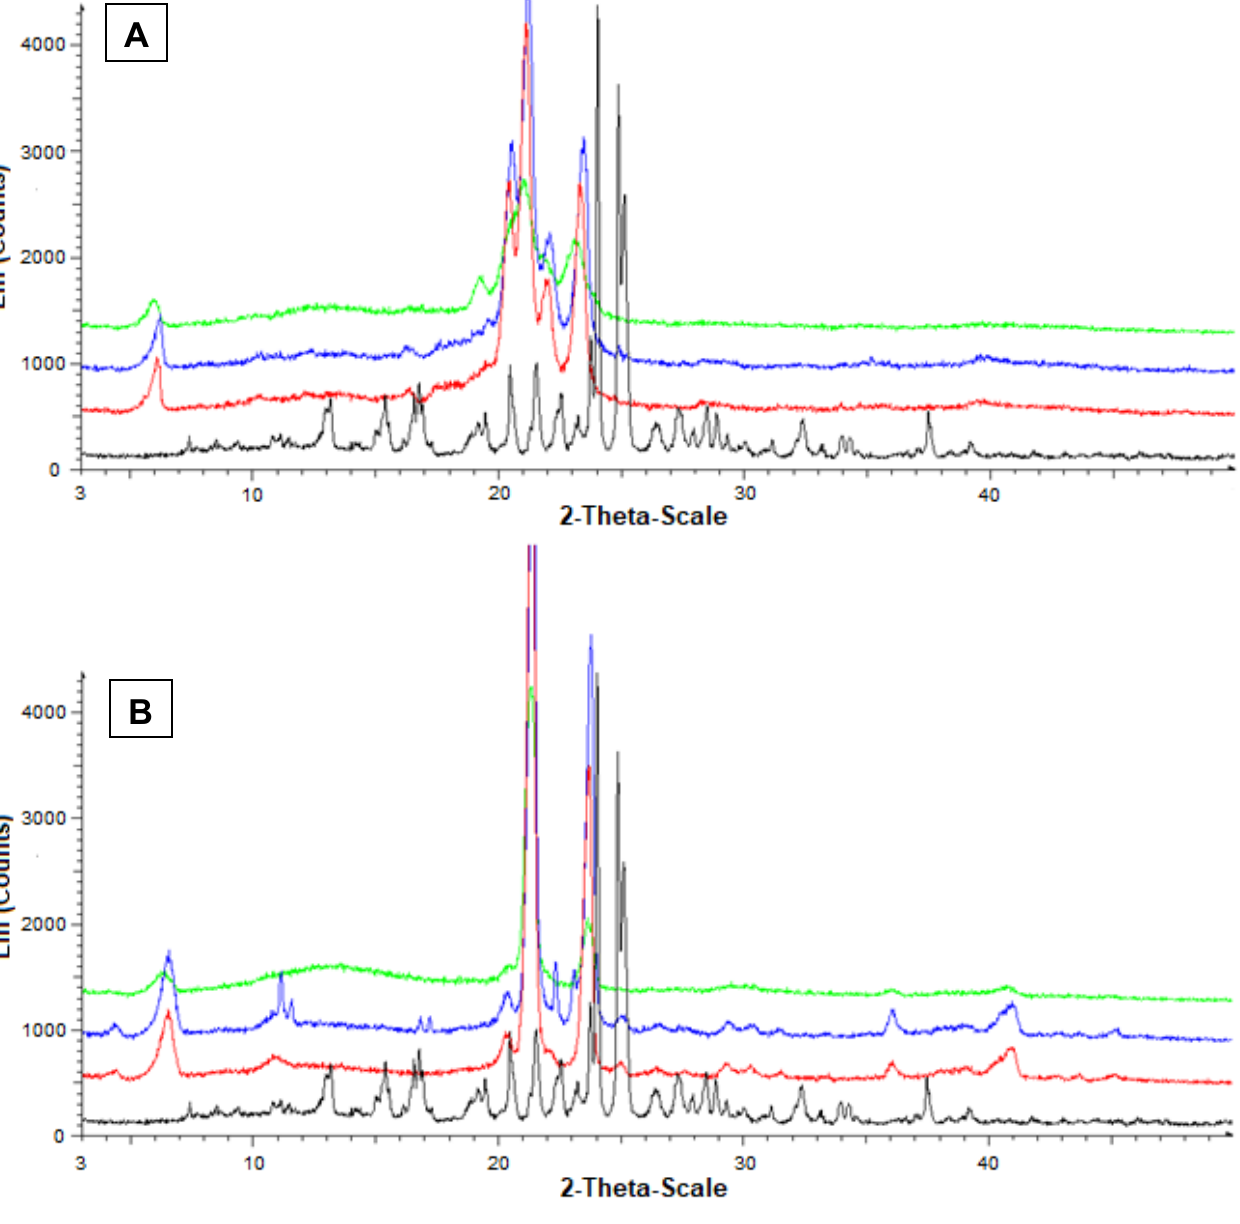
Figure 7. Powder X-ray diffraction patterns of Fer-Me (black), tristearin (red) ( A ) Stearic acid (red) ( B ) Drug lipid mixtures (blue) and loaded SLMs (green). ( A ) Diffraction patterns referred to tristearin and Fer-Me; ( B ) Diffraction patterns referred to stearic acid and Fer-Me.